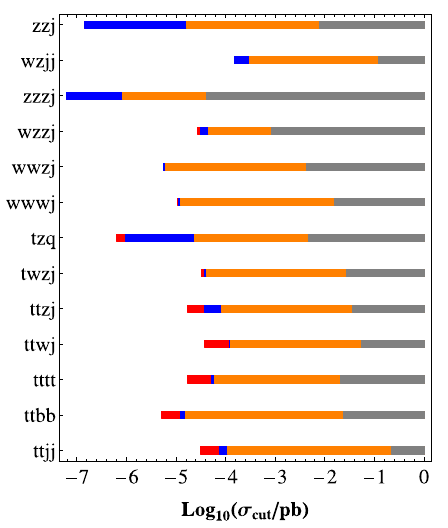
Fig. 7 Cut flow of the background processes. The left endpoints of the gray, orange, blue and red bands correspond to the cross sections after Cut-3 to Cut-6,